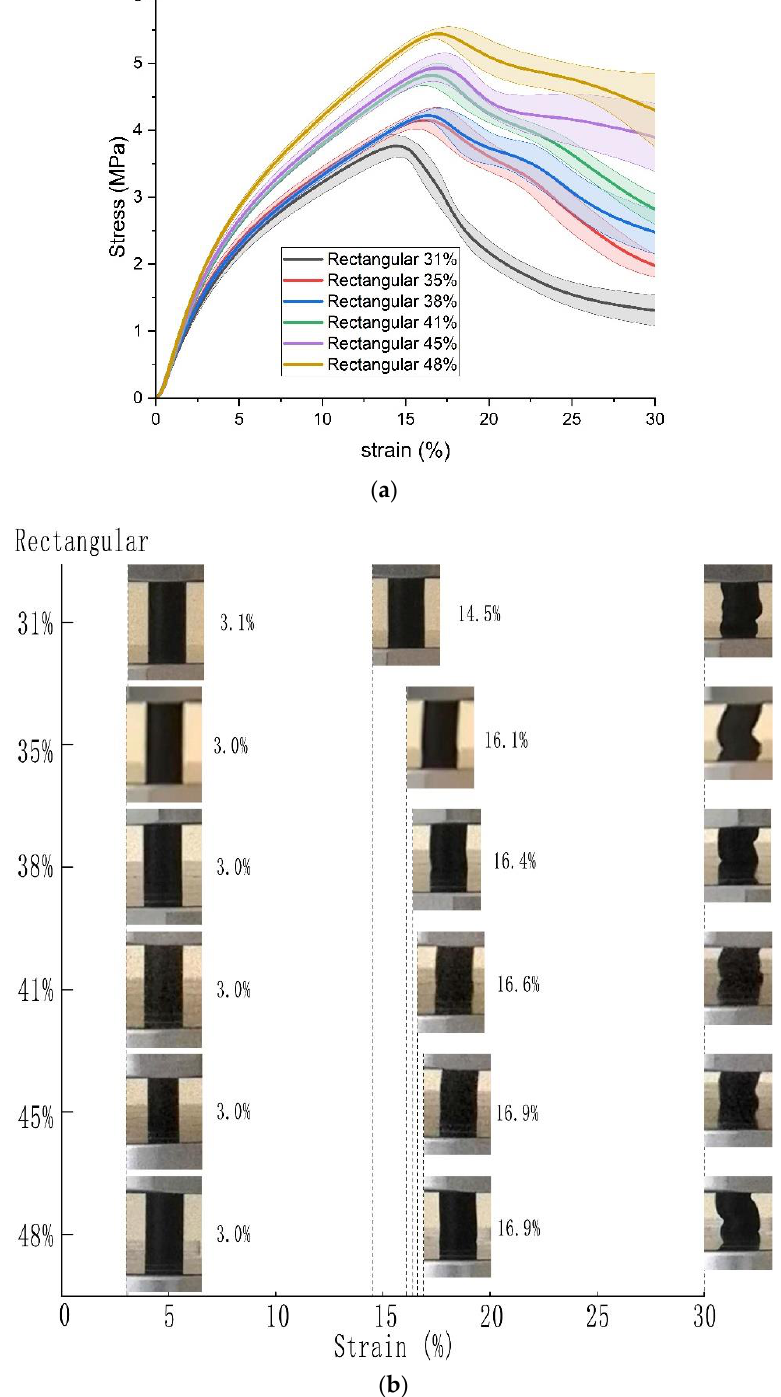
Figure 8. Results of Standard Specimens with rectangular fill. ( a ) stress versus strain; ( b ) appearance. Overall, the stress-strain curves of the three infill patterns show similar trends within and among the groups. All curves of three infill patterns include three stages. The first stage is the elastic deformation stage, where the stress increases rapidly with increasing strain. Then, in the plastic deformation stage, the slope of stress to strain reduces. Finally, after the appearance of the ultimate compressive strength, with increasing strain, the stress decreases or